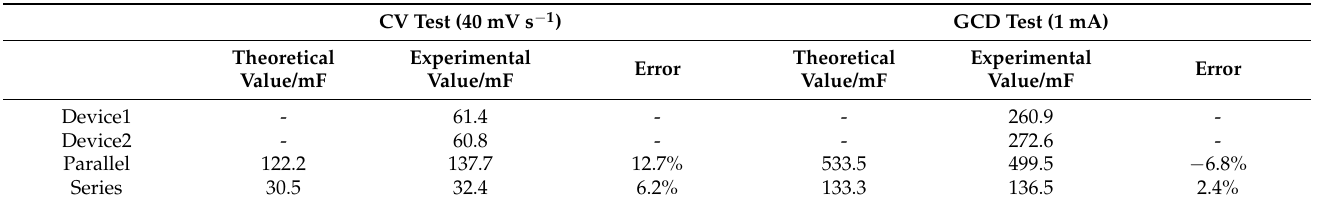
Figure 10. ( a ) CV curves. ( b ) GCD curves of two fabricated devices in parallel and series connections; ( c ) schematic diagram and optical picture of the circuit consisting of three as-fabricated WASCs to illuminate a LED. Table 1. Comparison of the theoretical values and experimental values of Device1, Device 2 and their combinations.